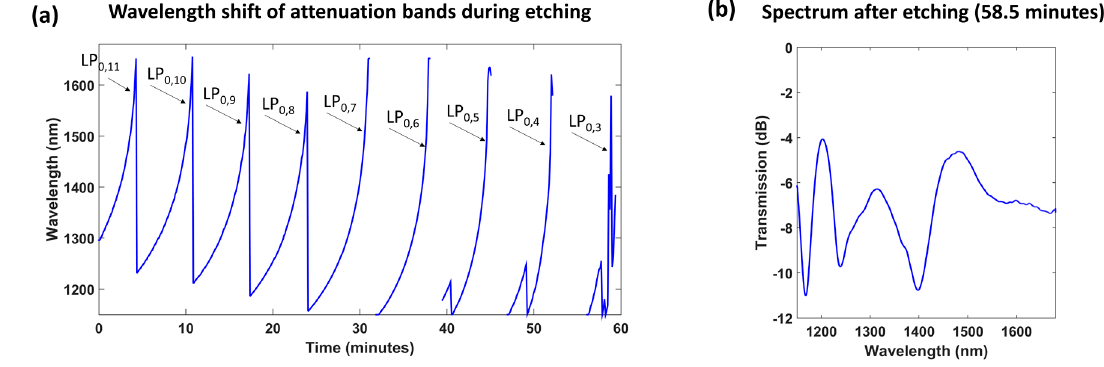
Figure 2. ( a ) Tracking of the attenuation bands in an LPFG with initial diameter 125 µm during etching process; ( b ) Spectrum at minute 58.5 corresponding with coupling to LP 0,3 cladding mode (the left band of the DTP is spread into three